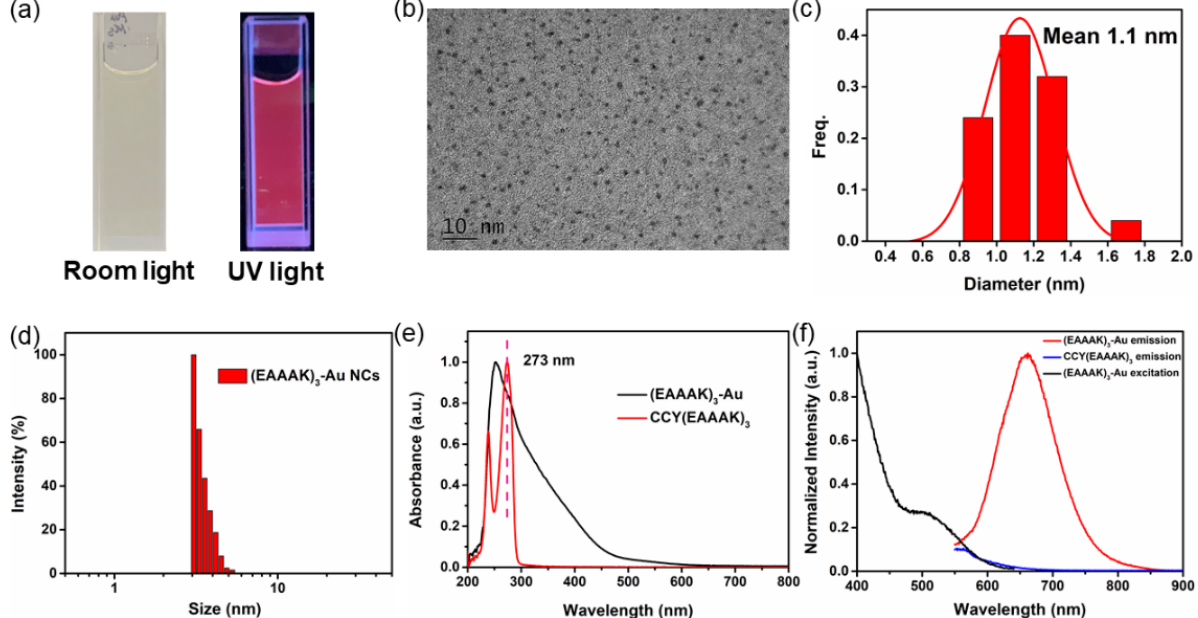
Figure 4. Characterizations of prepared (EAAAK) 3 -Au NCs. ( a ) Photographs of (EAAAK) 3 -Au NCs under room light and UV light. ( b ) TEM image of the (EAAAK) 3 -Au NCs. ( c ) The diameter distribution histogram of the (EAAAK) 3 -Au NCs. ( d ) Hydrodynamic diameter distribution of the (EAAAK) 3 -Au NCs. ( e ) UV-Vis spectra of CCY(EAAAK) 3 and (EAAAK) 3 -Au NCs. ( f ) Fluorescence excitation (black) and emission spectra of the (EAAAK) 3 -Au NCs (red) and CCY(EAAAK) 3 (blue).